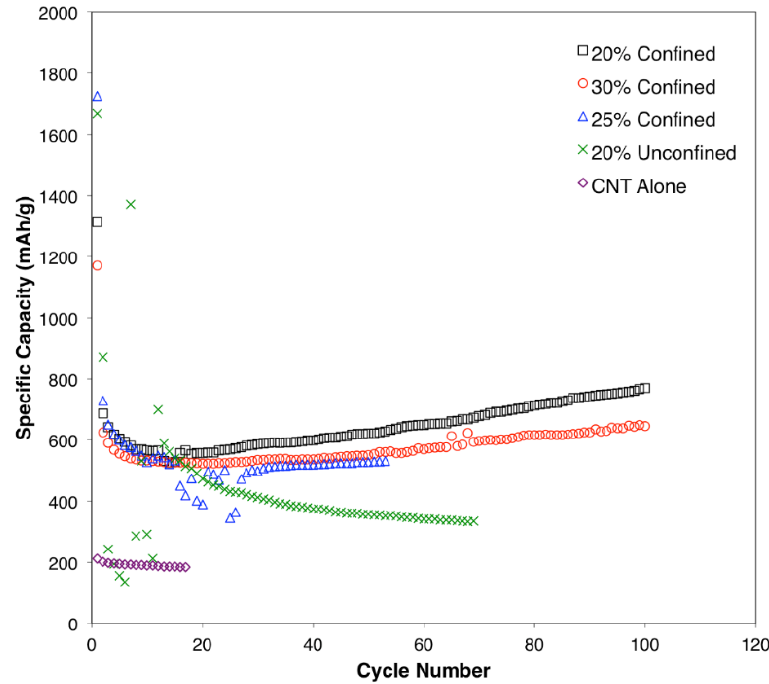
Figure 7. Cycle performance for the synthesized anode materials.